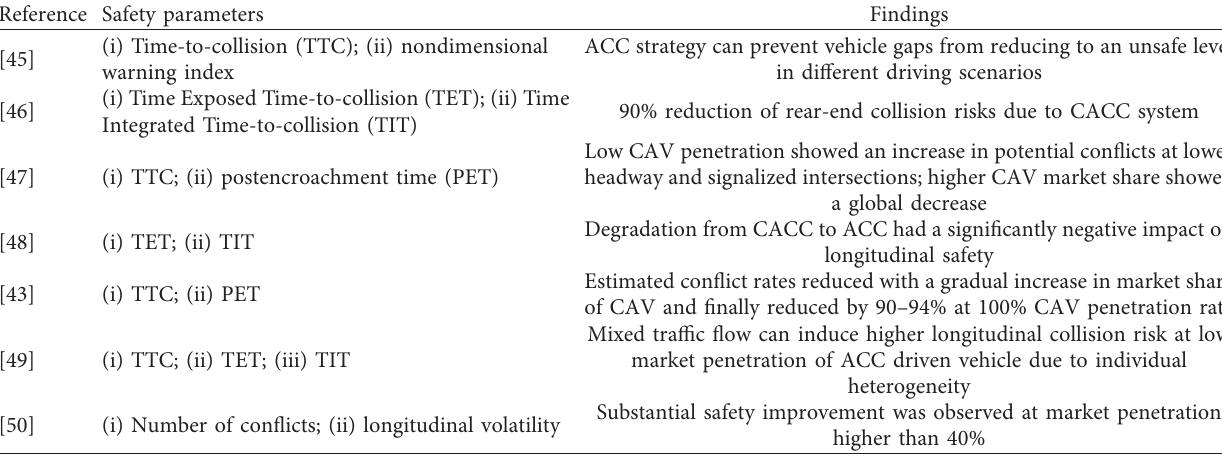
Table 1: Research summary of safety in mixed traffic